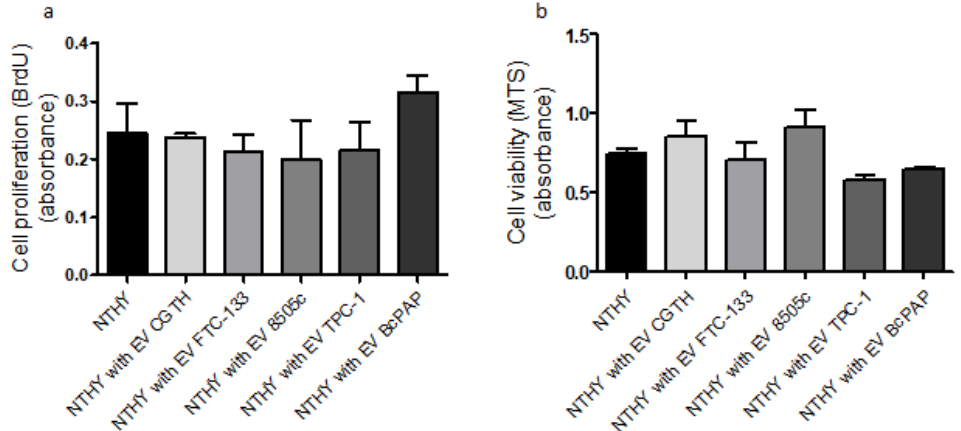
Figure 7. The effect of thyroid cancer-derived extracellular vesicles (EVs) on NTHY (normal thyroid) cell proliferation and viability. ( a ): cell proliferation results by BrdU assay; ( b ): cell viability results by MTS assay.